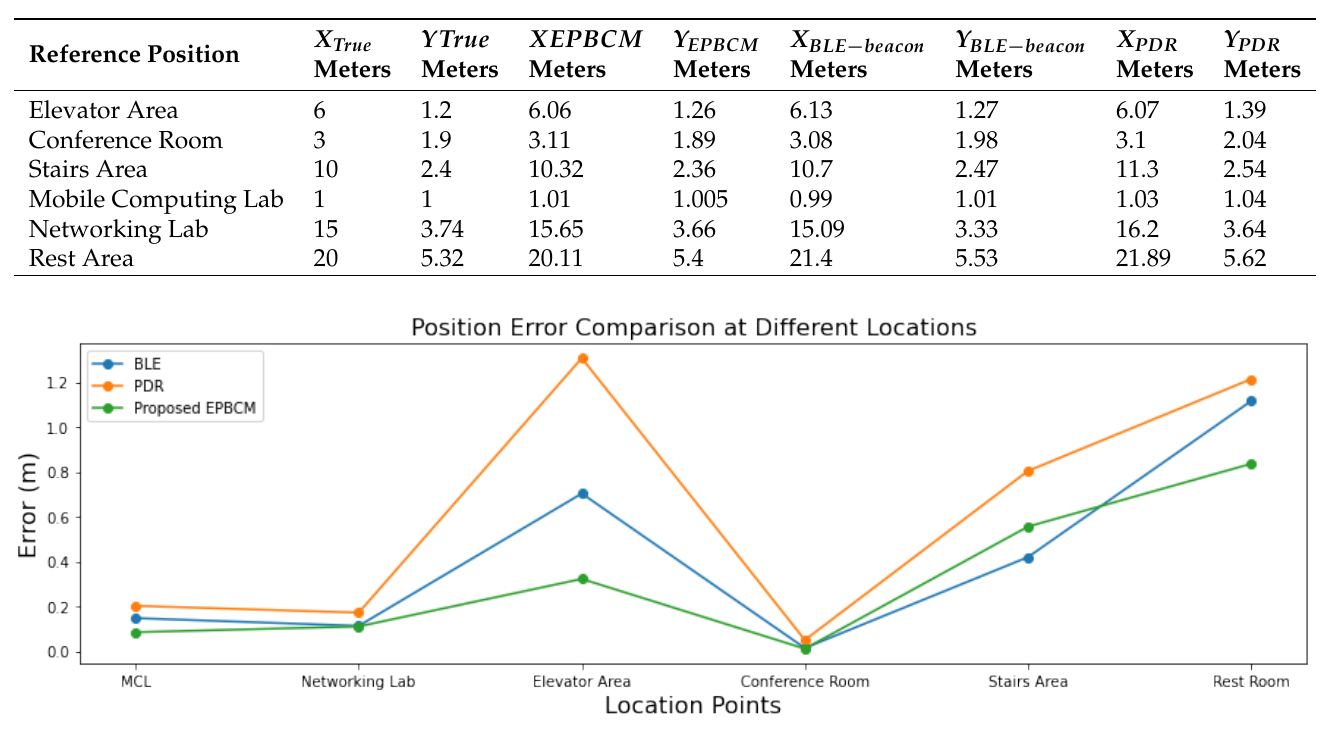
Table 7. Comparison of reference position with EPBCM, PDR, and BLE-beacon-based localization algorithms.